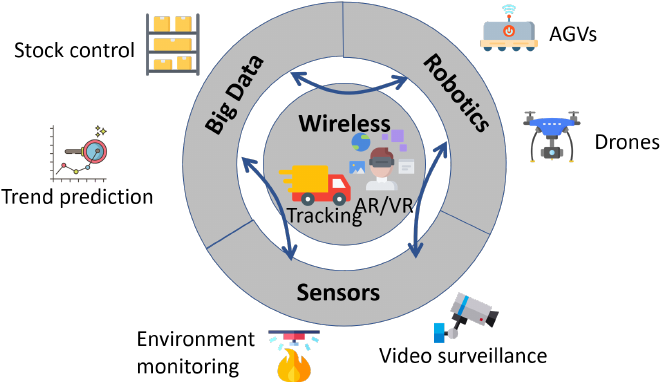
Figure 1. Industry 4.0 technologies and their